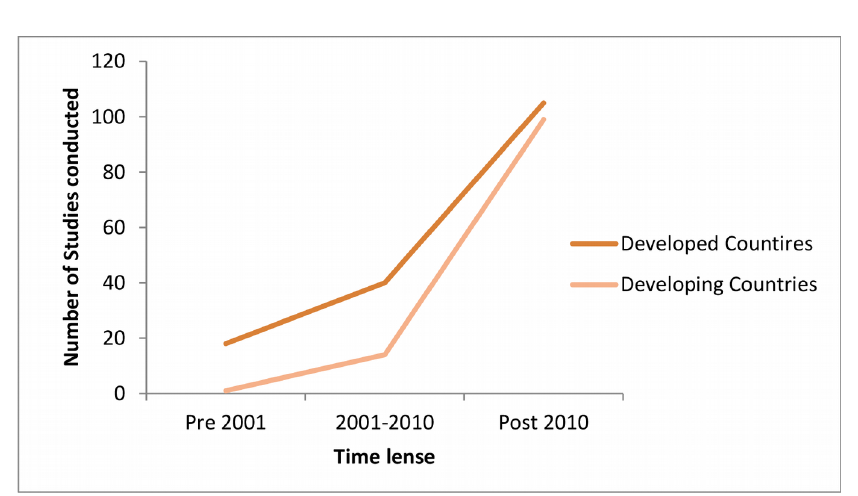
Figure 3. Lean publication: Developed Countries vs. Developing